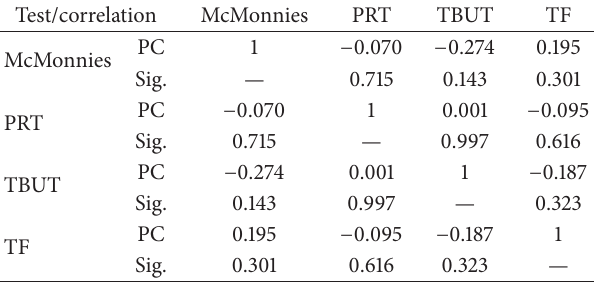
Table 3: Correlation between McMonnies questionnaire scores, PRT, TBUT, and TF grades within nonsmoker subjects ( 𝑁 = 30 ).